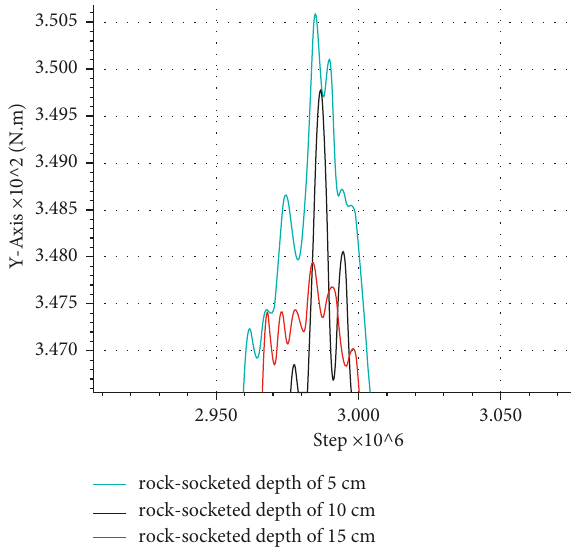
Figure 18: Magnified diagram of time-history curve at the anchor- stayed piles under different rock-socketed